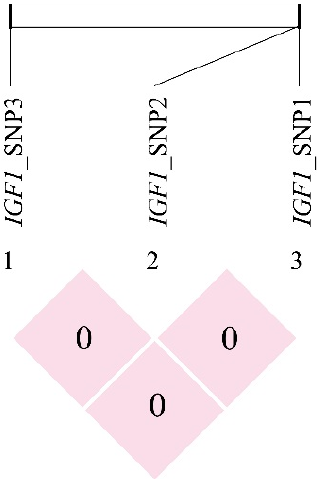
Figure 6. Linkage disequilibrium plot ( r 2 ) and haplotype blocks for SNPs of the IGF1 gene in Hulun Buir sheep. The values within boxes are pairwise SNP correlations ( r 2 ) and light red boxes represent very weak LD ( r 2 < 0.001).